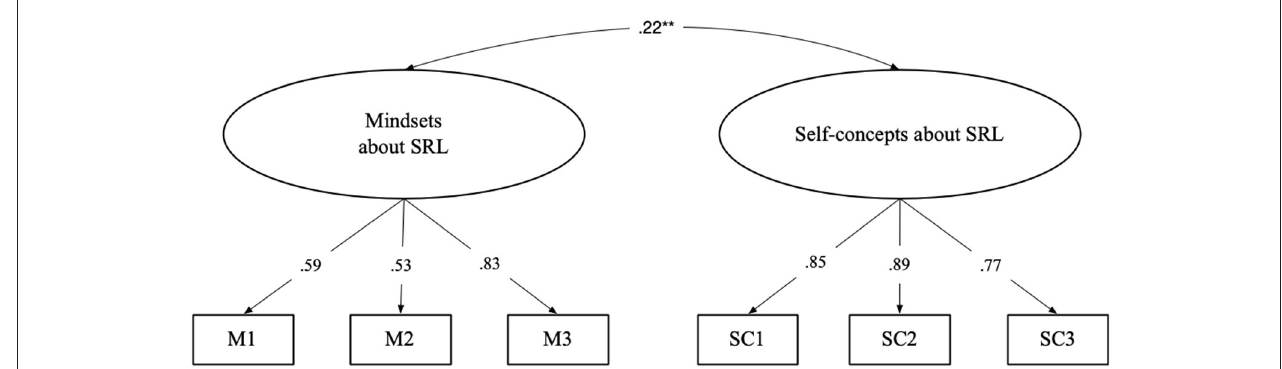
FIGURE 2 | Path analysis model of associations between implicit theories of SRL, self-concept about SRL, emotions, strategy knowledge, and academic achievement. Continuous lines represent significant paths; dotted lines represent non-significant but estimated paths. Standardized regression coefficients are presented. Gender is coded as 1 = female; 2 = male. Academic track is coded as 1 = higher track; 2 = lower track. * p < 0.05. ** p < 0.01. *** p < 0.001.